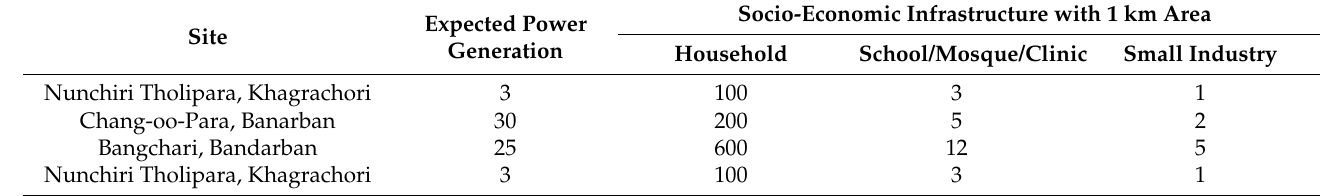
Table 2. Potential micro-hydropower sites in Bangladesh [57].